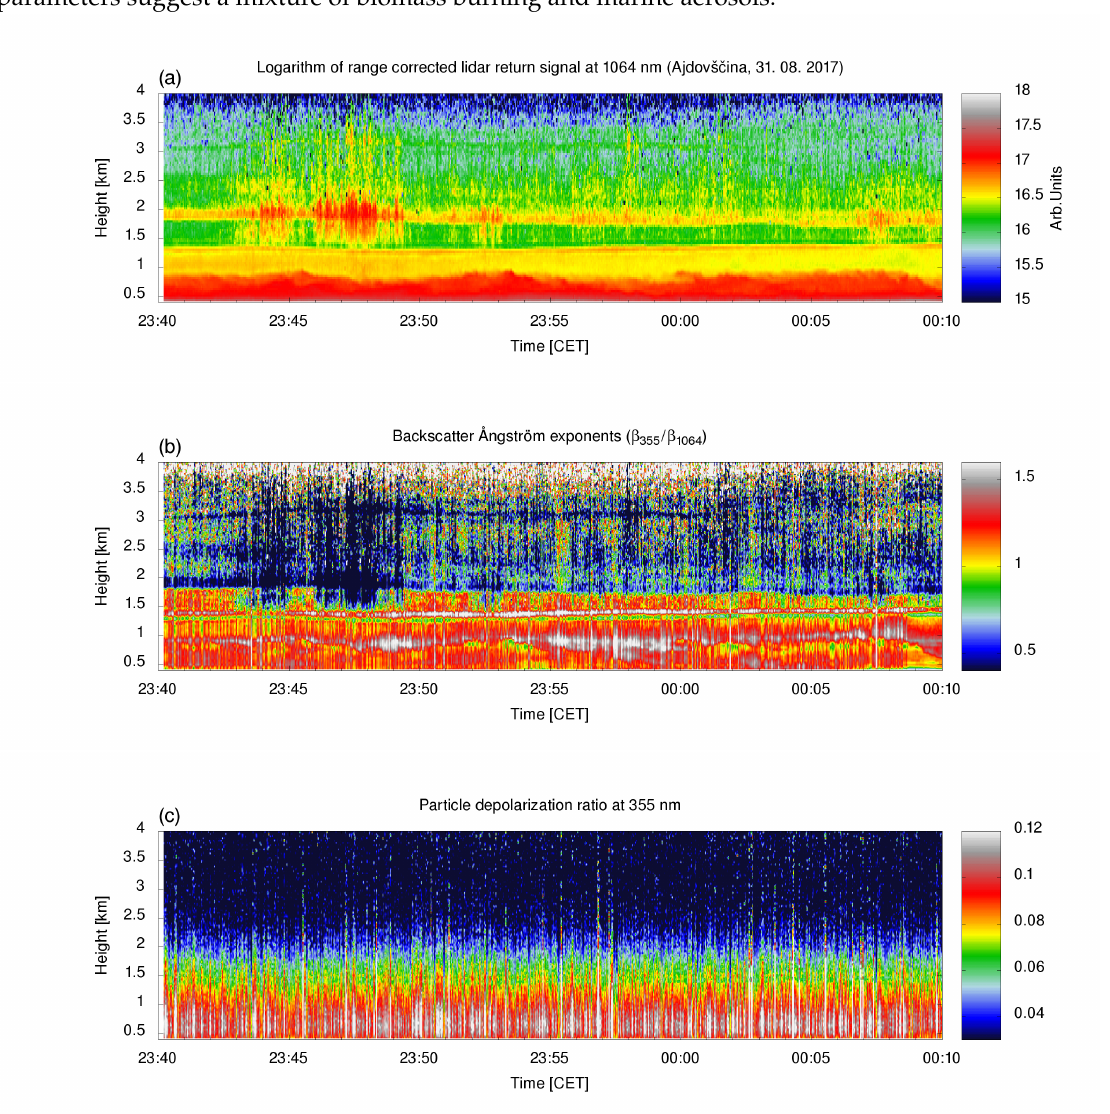
Figure 4. Temporal variations of the IR LiDAR return ( a ), BAE ( b ) and PDR ( c ) in stable atmosphere conditions on 31 August 2017 between 23:40 CET and 00:10(+1) CET show stratified atmosphere with no apparent mixing between different layers. PBL was found to be below 0.7km, the residual layer (RL) between 0.7km and 1.4km and an elevated aerosol layer (EAL) above 1.7km with peak aerosol concentration at about 2km. All data was re-sampled to 18.75m range resolution. The values are shown for heights within the complete LiDAR overlap range. The heights are relative to